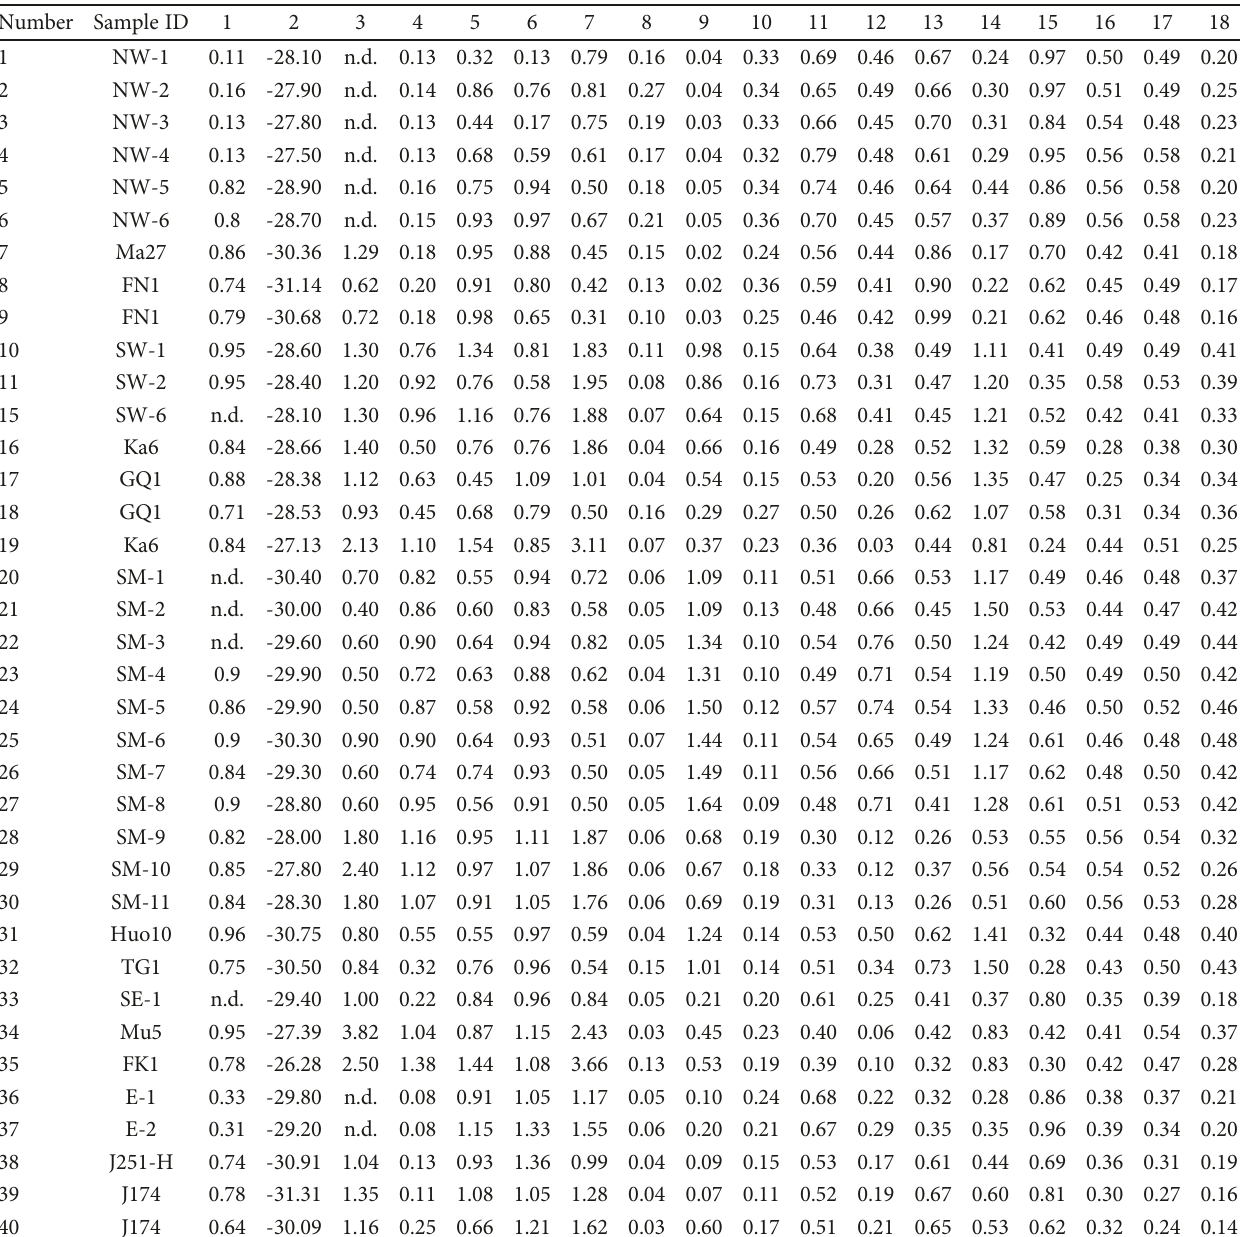
Table 2: Molecular geochemical data of oil and gas seeps, selected crude oil, and source-rock samples from the Junggar Basin. Number Sample